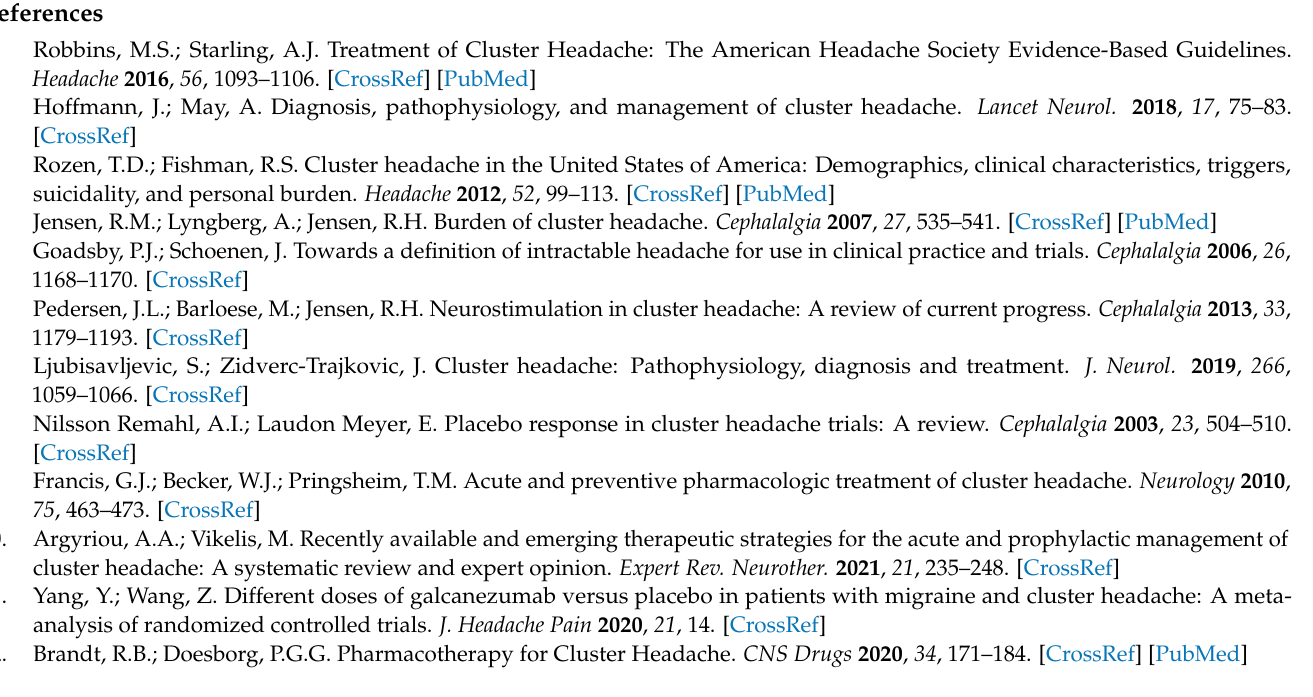
Figure S3: Direct and indirect comparison in terms of duration of attacks; Figure S4: Direct and indirect comparison in terms of duration of attacks; Figure S5: Direct and indirect comparison in terms of adverse events; Figure S6: Meta-regression results with male proportion and age. Table S1: The result of surface under the cumulative ranking curve (SUCRA) for frequency of attacks; Table S2: The result of surface under the cumulative ranking curve (SUCRA) for pain-free rate; Table S3: The result of surface under the cumulative ranking curve (SUCRA) for duration of attacks; Table S4: The result of surface under the cumulative ranking curve (SUCRA) for number of patients using rescue agents; Table S5: The result of surface under the cumulative ranking curve (SUCRA) for frequency of